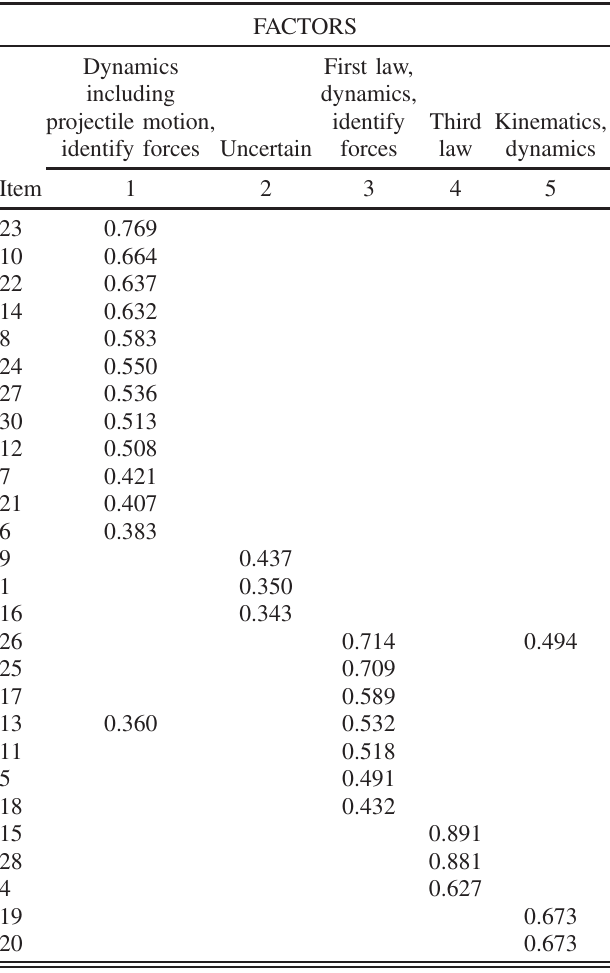
TABLE III. The absolute values of the loadings 0.340 and higher are shown for the model of Table II. Also, the item ordering reflects the ordering of the loading values. An identi- fication of the factors is attempted. Only one of the five factors is simply identified with specific force concepts. The others concern a mixture of Newtonian